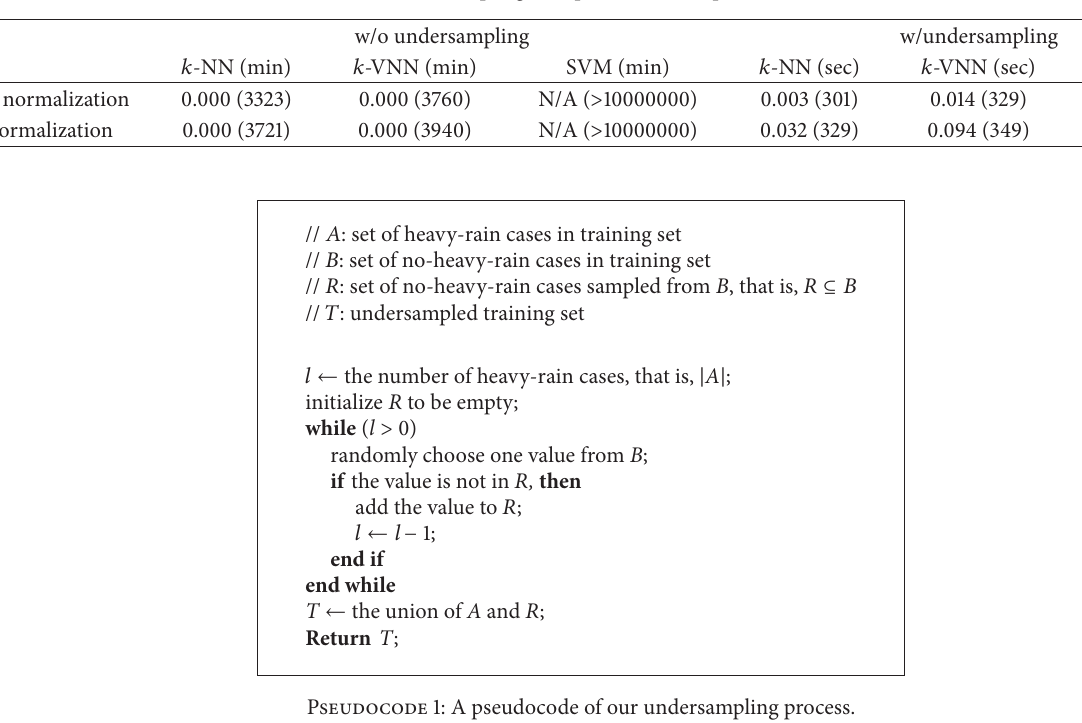
Table 4: Effect of undersampling (sampled 3 stations, prediction after 3hours).